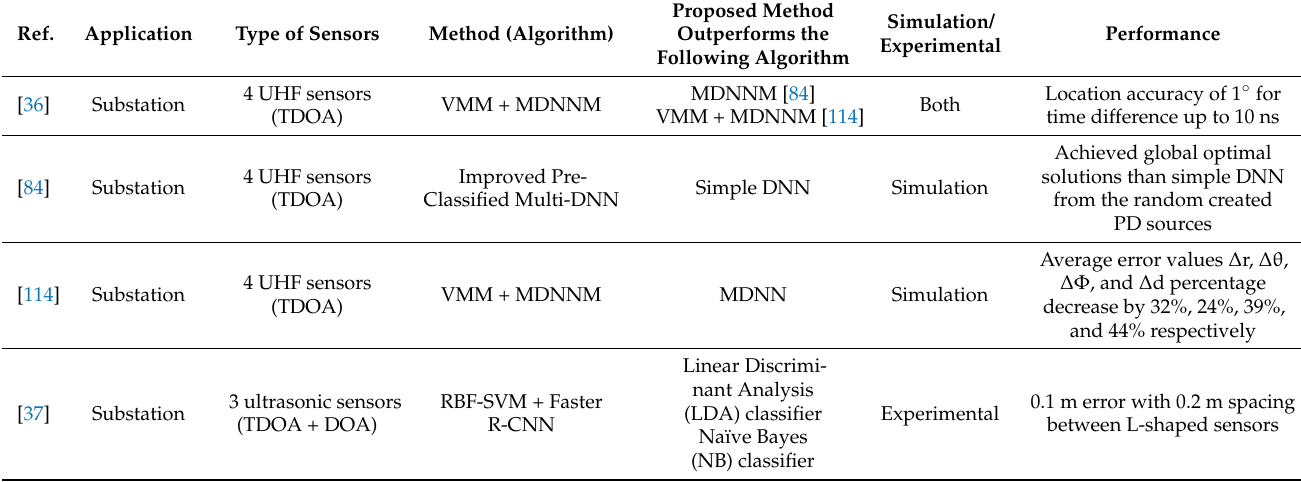
Table 6. DL PD localization.